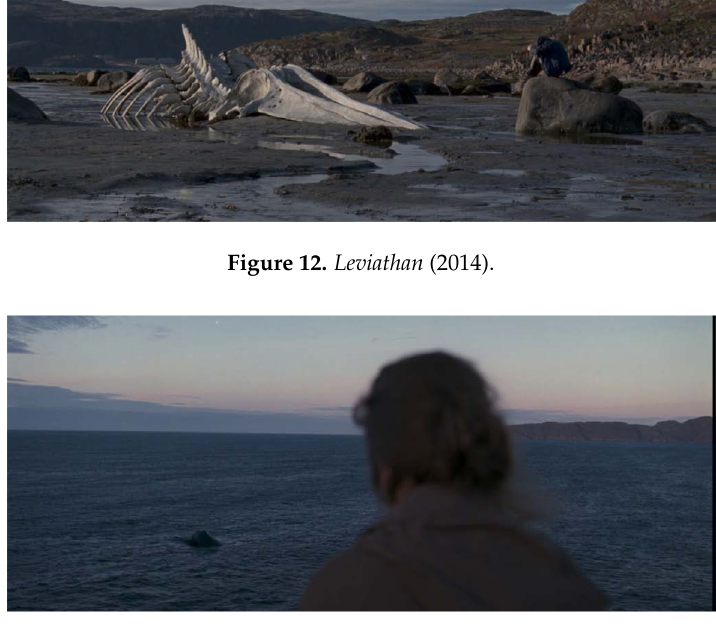
Figure 13. Leviathan (2014).